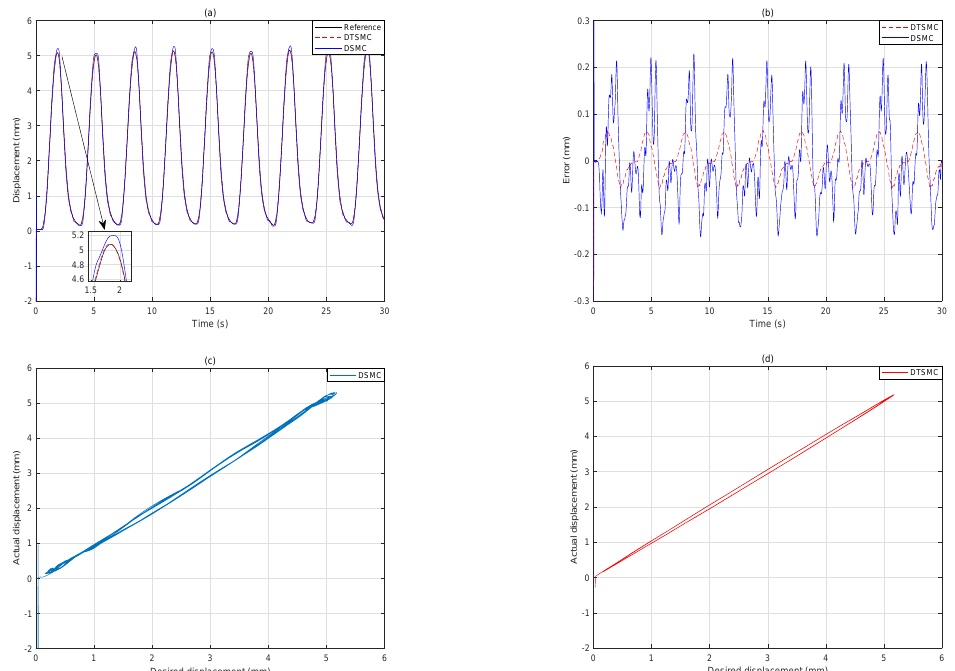
Figure 12. The tracking results under 0.3 Hz input signal. ( a ) Displacement output. ( b ) Tracking error. ( c ) Desired displacement versus actual displacement of the DSMC. ( d ) Desired displacement versus actual displacement of the